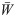
Graphs of W¯ versus: (a) θ0, (c) the mean, as well as (d) median phase differences, respectively.The effective phase difference θeff during steady state being the median phase difference between the two buses more closely matches the predicted value from Eq (15), compared to the mean phase difference. Note that below the lower bound θ0 = θmin, W¯ blows up by two orders of magnitude (not plotted): W¯=10.4 at θ0 = 191°, W¯=31.5 at θ0 = 190°, W¯=54.6 at θ0 = 189°, …. Similar graphs can be obtained for any value of k. (b) The relationship between θ0 and the mean as well as median phase differences as measured from the simulations.